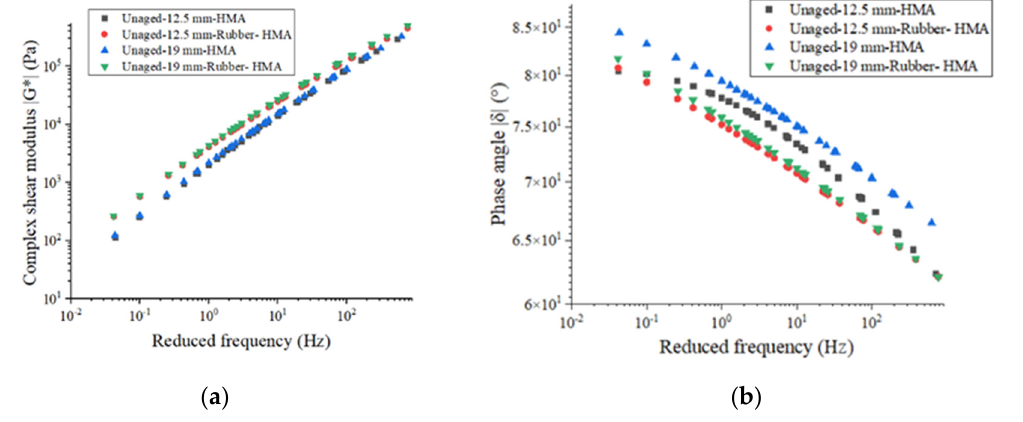
Figure 6. The master curves of the asphalt binder. ( a ) G* master curve @ 58 °C; ( b ) phase angle master curve @ 58 °C.